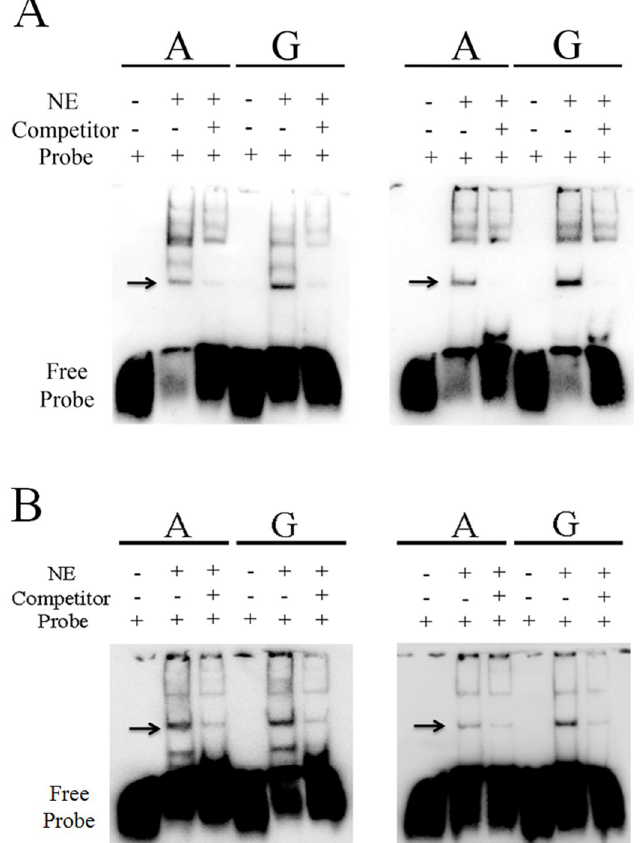
Fig 7. Binding affinity difference of rs66651343 and rs12909095 alleles in Beas-2B (A) or A549 (B) cell. For each part, the left chart is for rs66651343 while the right one for rs12909095. The top line indicates different alleles. NE denotes nuclear extracts, and the arrow points out the position of protein-probe